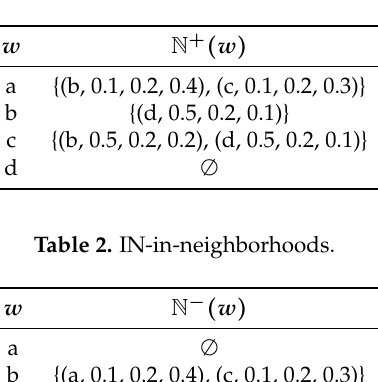
Table 1. IN-out-neighborhoods.